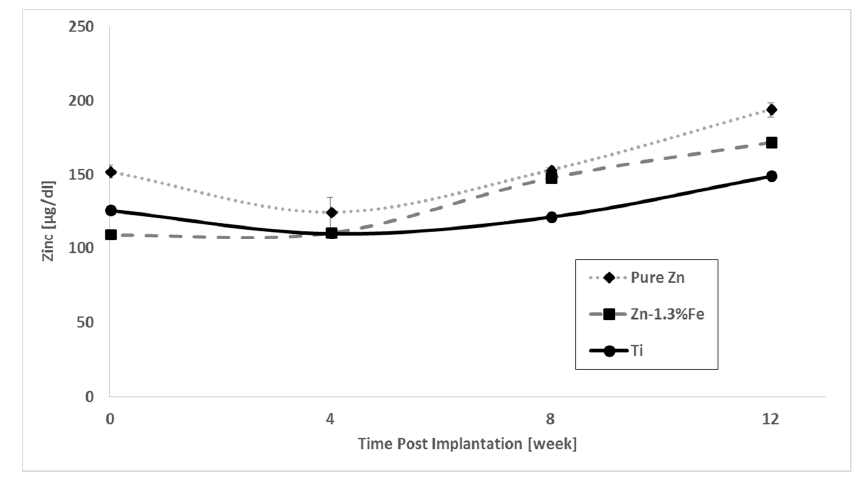
Figure 11. Serum Zinc level pre- and post-implantation.